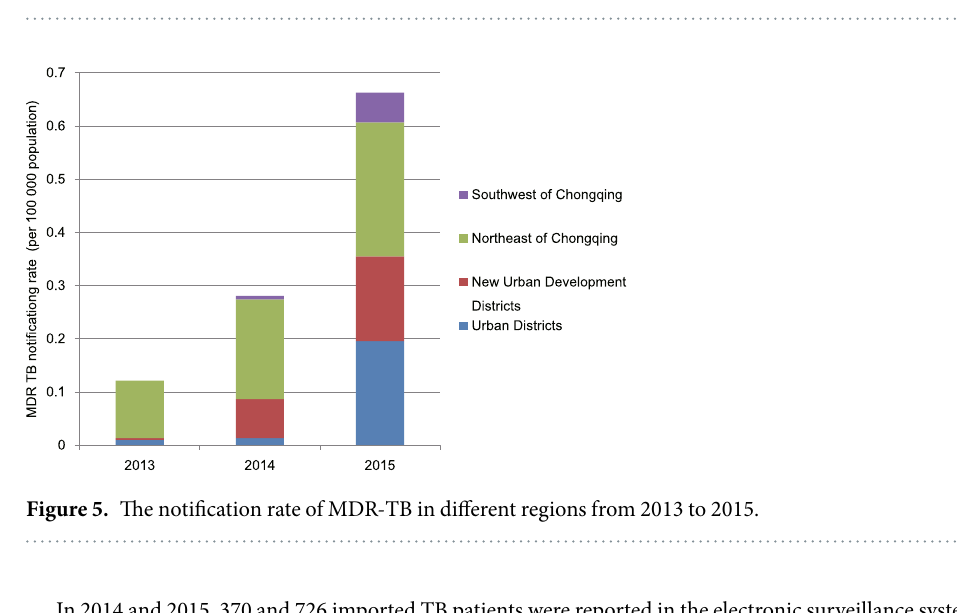
Figure 4. The notification rate of different regions from 2002 to 2015.